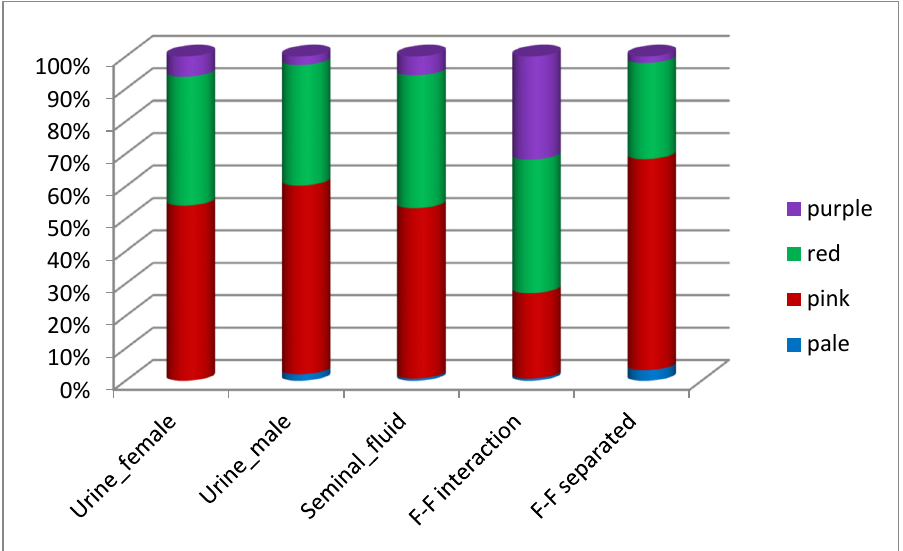
Figure 5. Receptivity rate (vulvar color) depending on the experimental group. Among variables statistical comparisons.